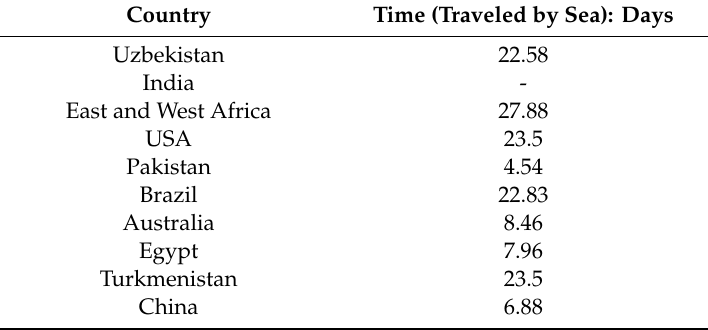
Table A19. Time required to travel from di ff erent countries to Bangladesh by ship